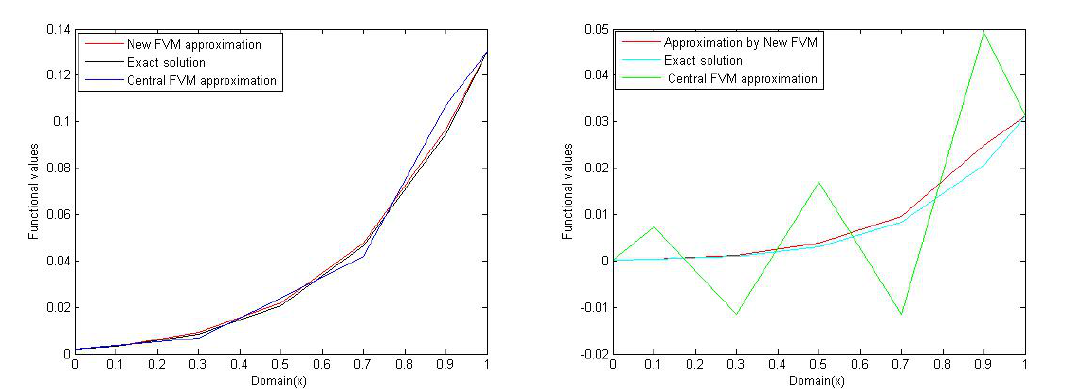
Figure 10. Comparison of numerical approximation with exact solution taking ∆ t = 1/3000, ∆ x = 1/5 for numerical example